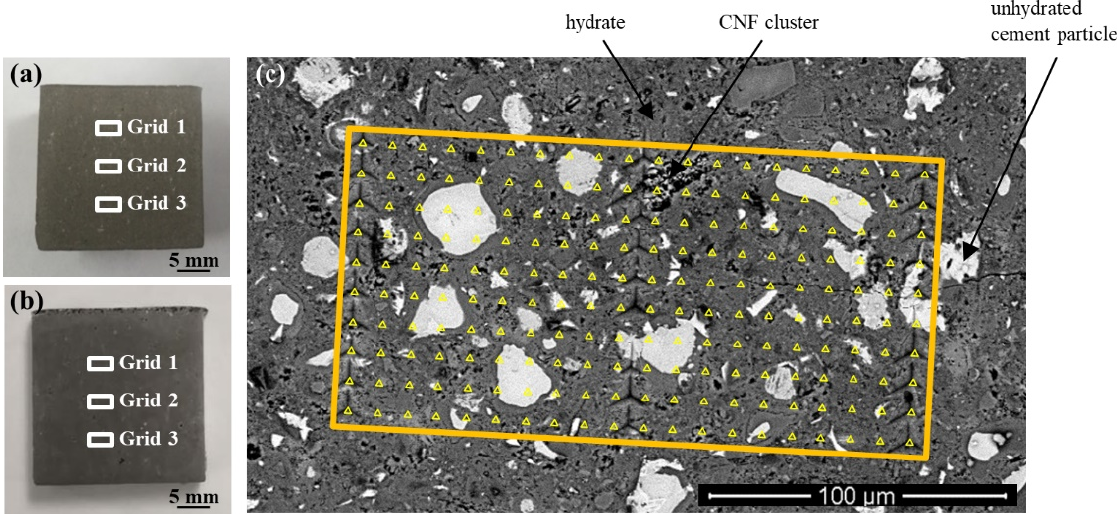
Figure 1. Cross-section of the ( a ) reference cement paste and ( b ) cement paste with CNFs showing the location of the nanoindentation grids and ( c ) SEM image of a representative nanoindentation grid showing 200 indents (yellow triangles are enlarged to show indent locations).